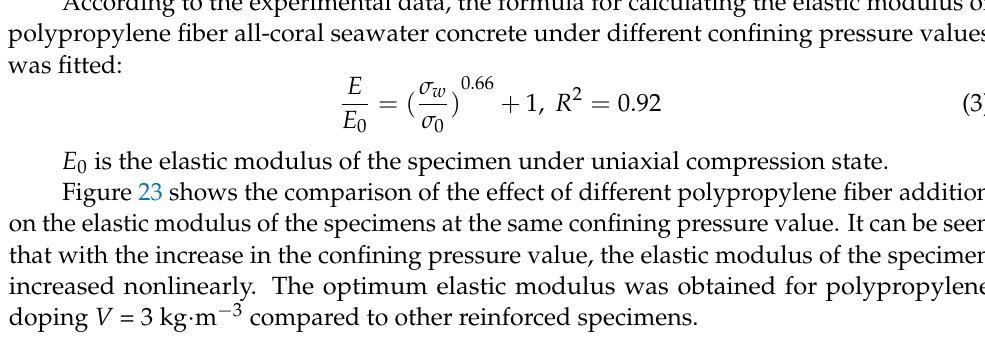
Figure 22. Relationship between elastic modulus and confining pressure value.